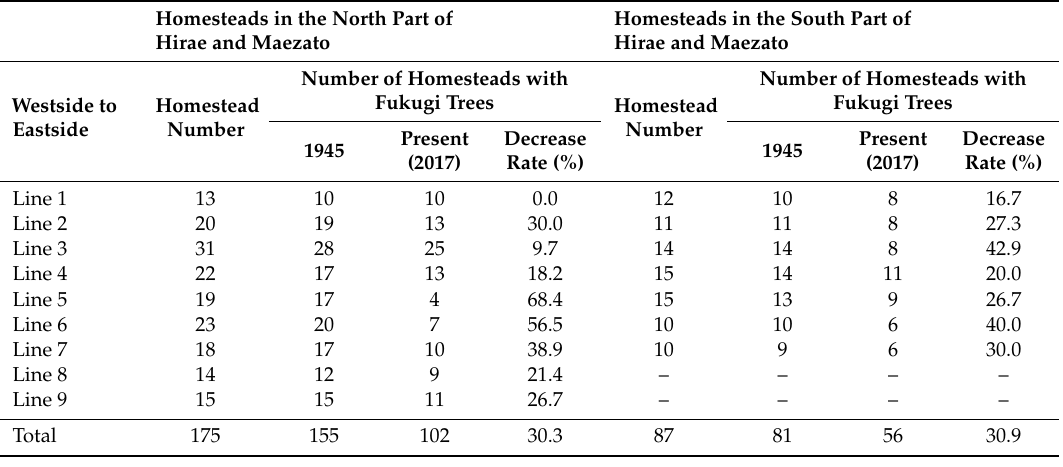
Table 3. Loss of Fukugi tree lines from 1945–2017 by geographic area.